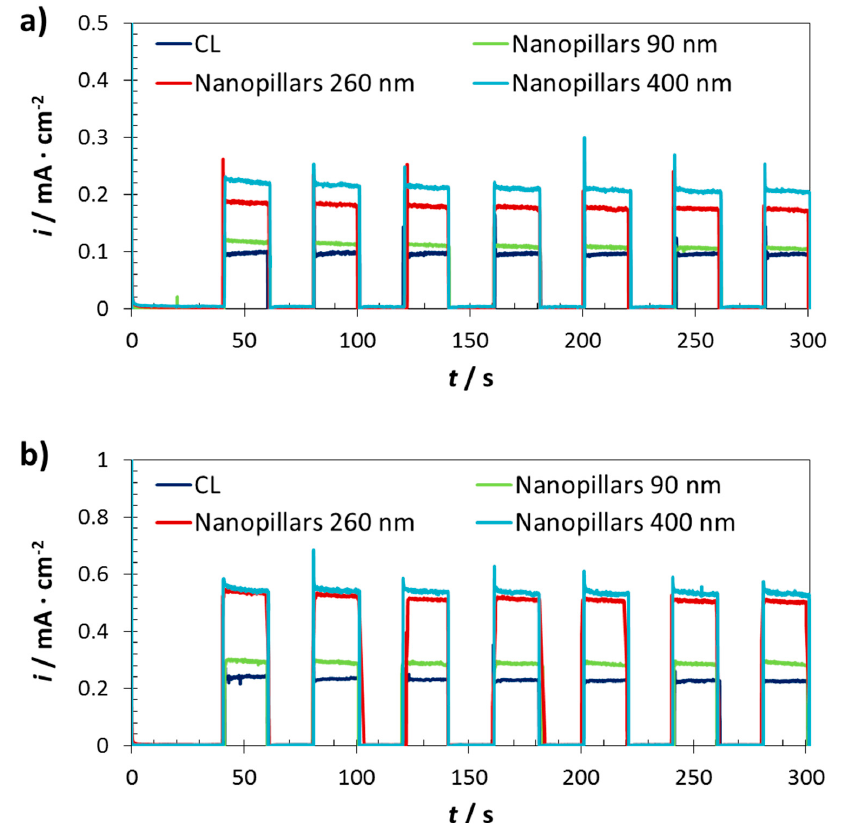
Figure 7. Chopped-light chronoamperometry measurements at 0.5 V (vs. Ag/AgCl) of the pho- toanodes fabricated on FTO substrates, under visible light ( λ > 420 nm) ( a ) and under solar AM 1.5 G (55 mW·cm − 2 ) illumination ( b ). (55 mW · cm − 2 ) illumination ( b